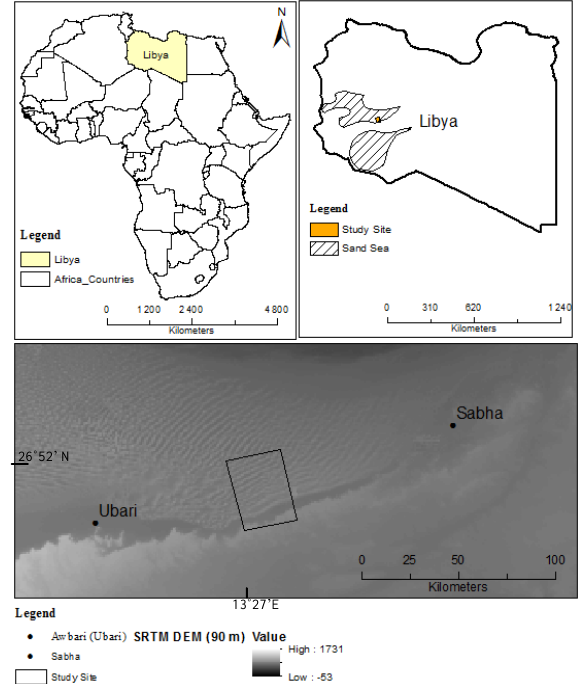
Figure 2: Location map of the study site (boxed in lower panel) and the towns Ubari and